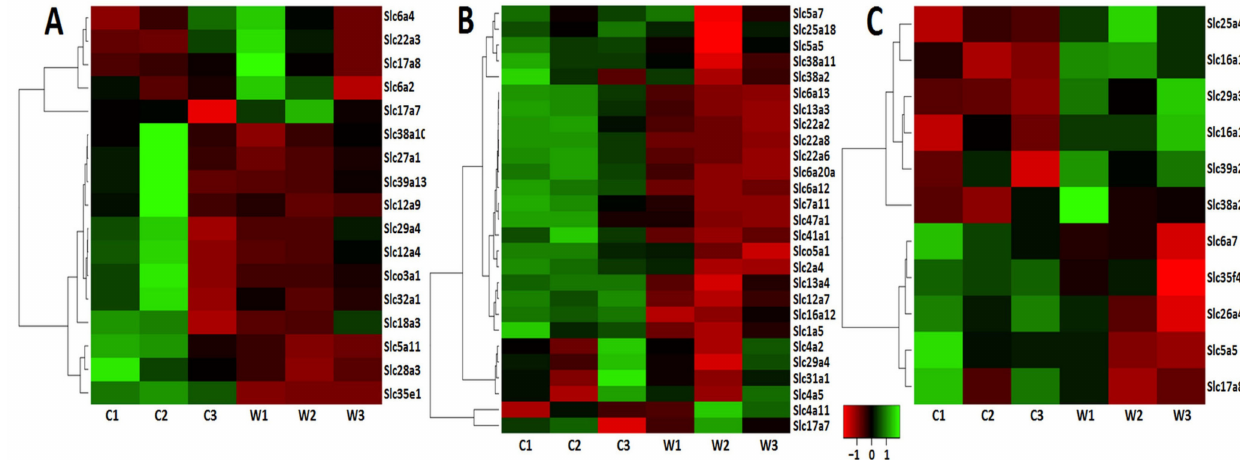
Figure 2. Heatmap visualization. The heatmap analysis based on expression profiles of the Slc* DEGs in the brain regions of the winners (W1, W2, W3) and control male mice (C1, C2, C3) in the VTA ( A ), NAcc ( B ), and PFC ( C ). The genes were clustered using linkage hierarchical clustering by Euclidean distance. The gene expression levels are shown with red for low, black for middle, and green for high expression